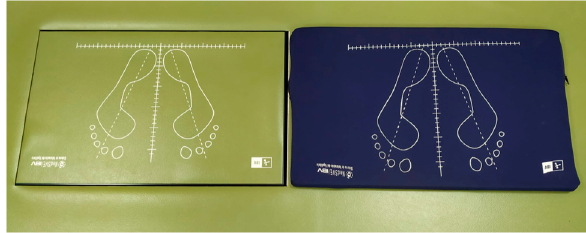
Figure 2. Foam rubber pad used in RGA and RGC.